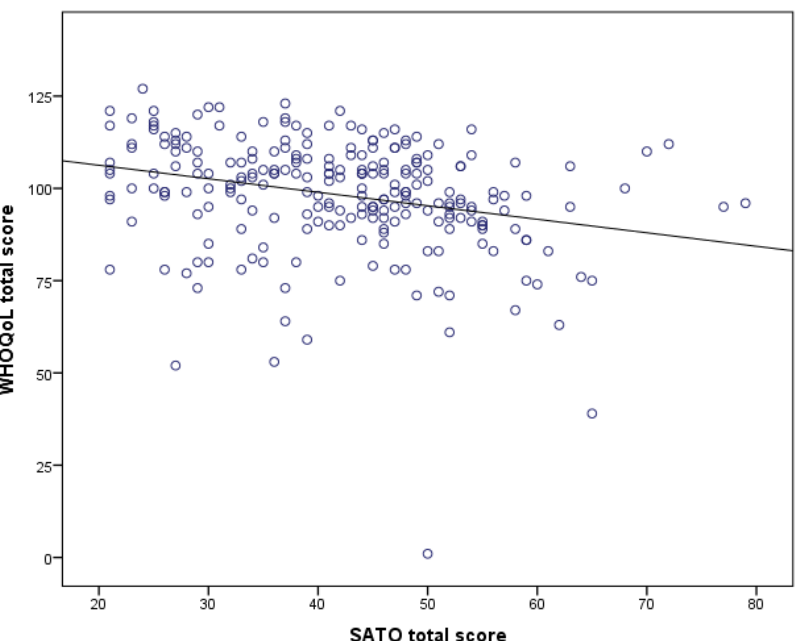
Figure 2. Linear association between WHO Quality of Life (WHOQoL) total score and Self-perception Attitudes Towards Old Age (SATO) total score. Pearson’s correlation, r = − 0.273, p < 0.0001.